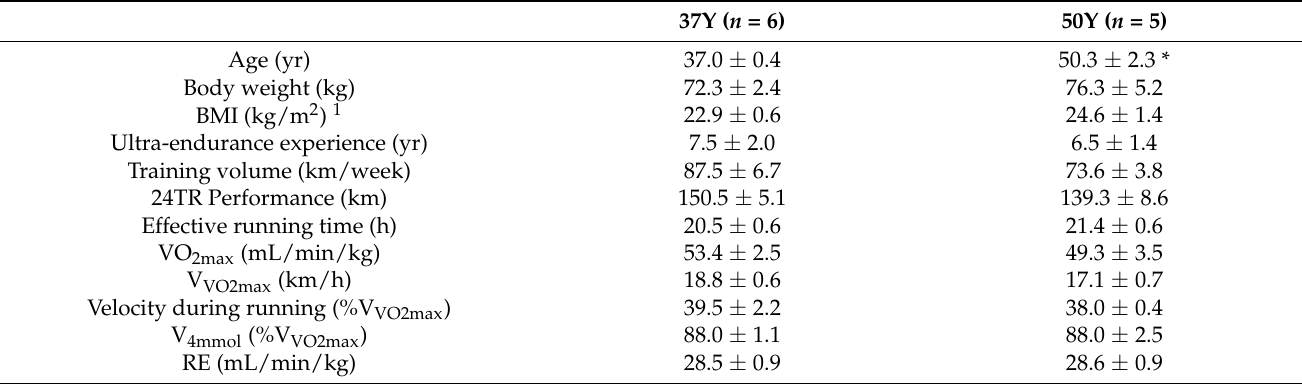
Table 1. Subjects